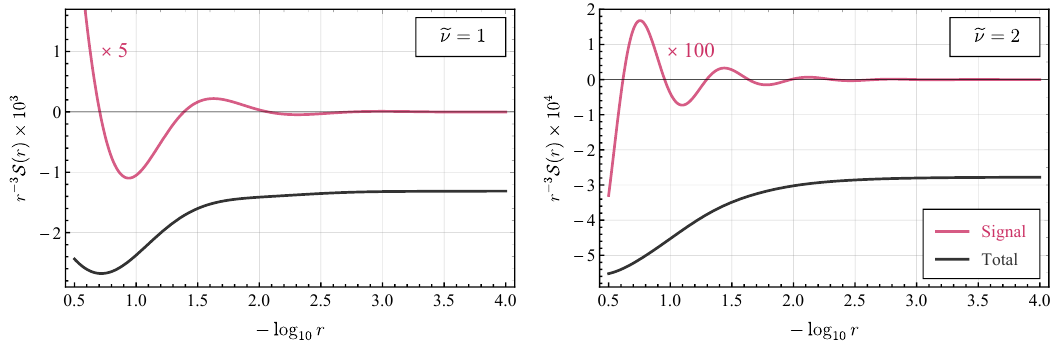
Figure 5 . The 1-loop inflaton bispectra of 1-loop scalar exchange with mass parameter magenta and black curves show the signal and the total result, respectively. We multiply the signal by a factor of 5 for ν = 1 and a factor of 100 for e regularization and the MS scheme, with the renormalization scale chosen at µ